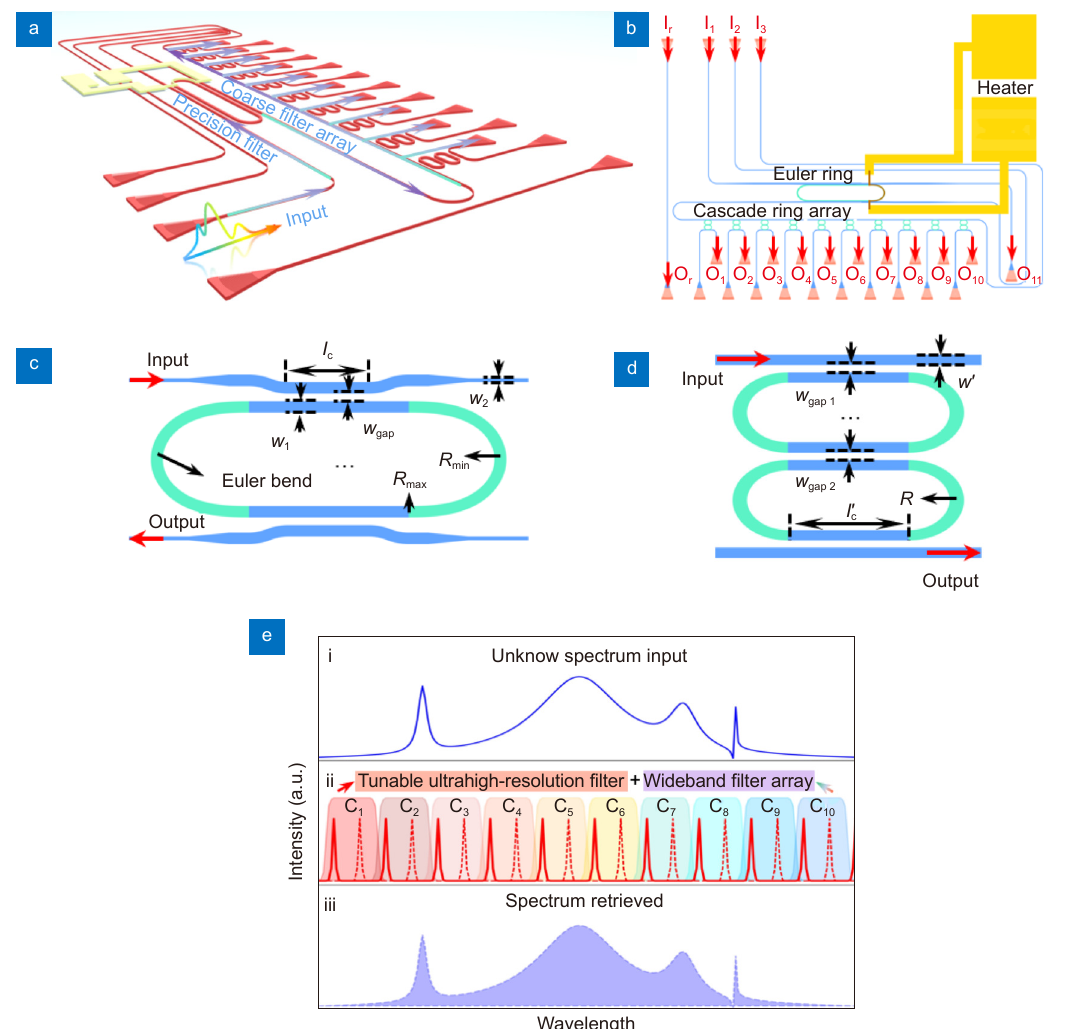
Fig. 1 | The 3D view ( a ) and the top view ( b ) of the present ultra-high-resolution on-chip spectrometer. Schematic configurations of the ultra-high- Q resonator ( c ) and the wideband resonator ( d ). ( e ) The principle of the spectrum retrieved